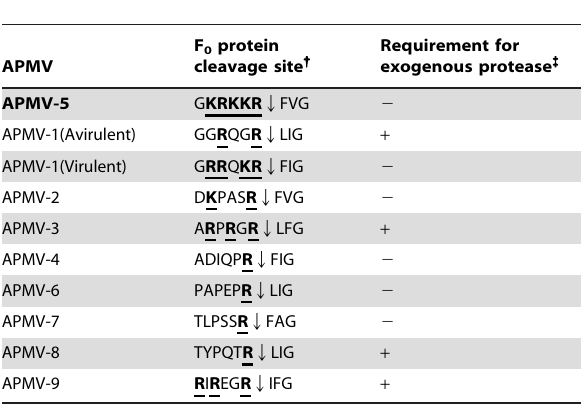
Table 6. Comparison of the putative cleavage sites of the F 0 proteins of prototypes strains of the nine APMV serotypes, and requirements for exogenous